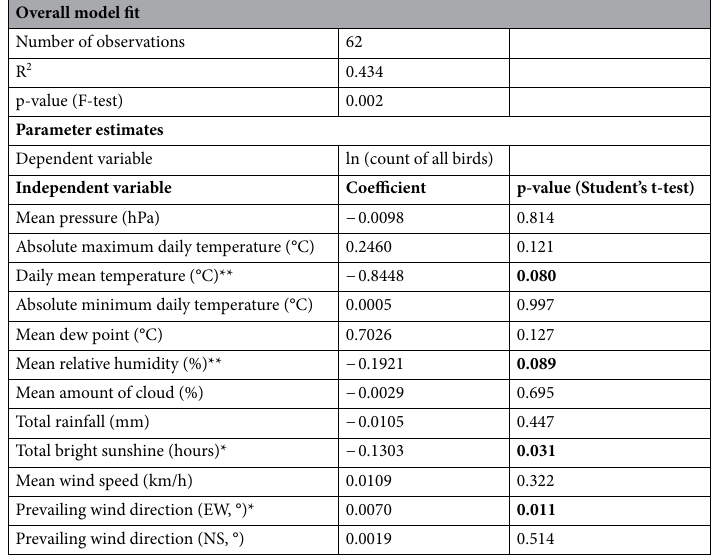
Table 1. Multivariable linear regression analysis. Results of the overall model fit and parameter estimates are compiled to examine the weather influence on the bird activities. Hypothesis testings were carried out at a significant level of 0.05. Bold values indicate the p-values less than 0.05 (statistically significant) and 0.10 (marginally significant). *Individual weather factors that are statistically significant to the count of all birds (p-value < 0.05). **Individual weather factors that are marginally significant to the count of all birds (p-value <